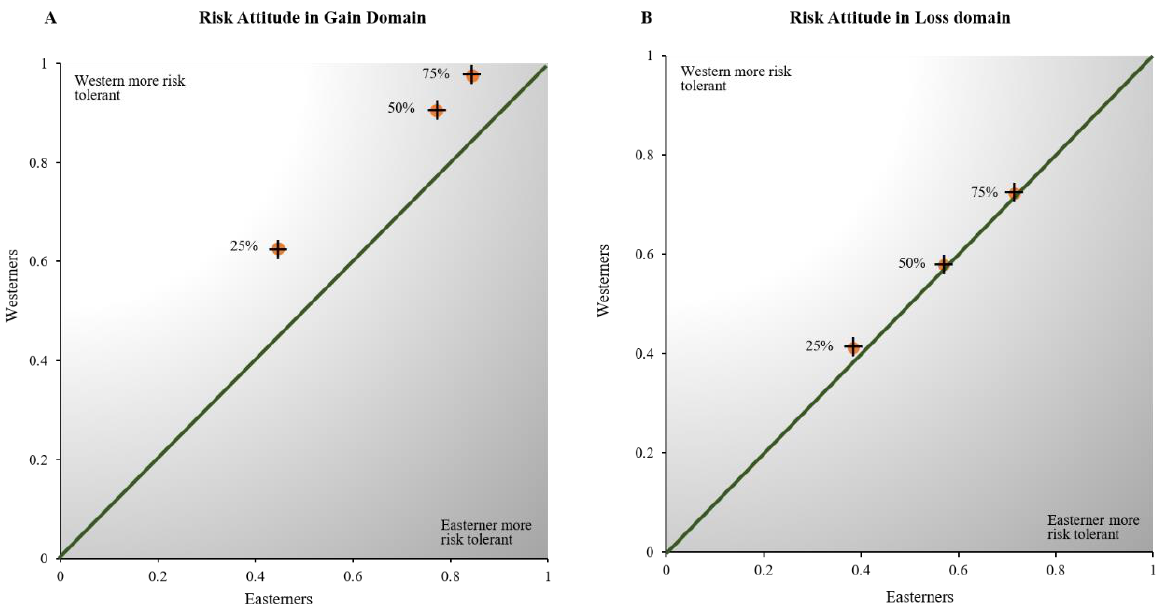
Figure 3. Comparison of risk attitudes in the Easterners and the Westerners. In ( A ) each point represents the average proportion of times that a risky lottery was selected over the certain amount RMB 5 by the Easterners and the Westerners. In ( B ), each point represents the average proportion of times that a risky lottery was selected over the certain amount RMB − 5 by the Easterners and the Westerners.